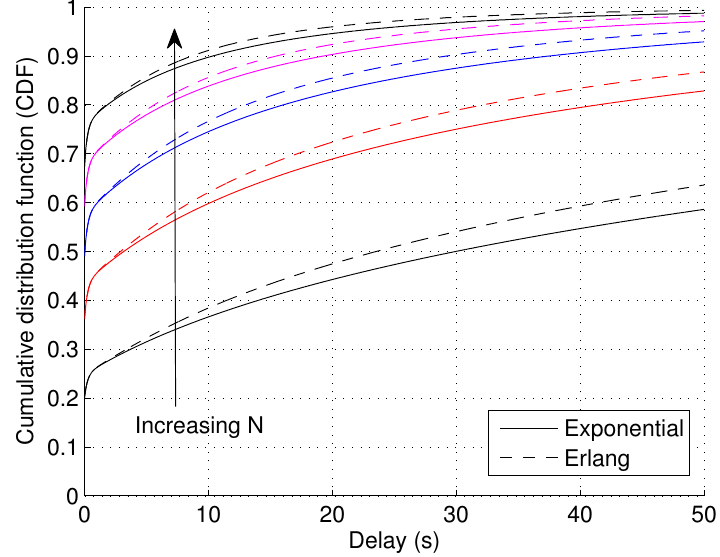
Figure 7. CDF of waiting time w II with varying number of collaborating devices N when the service outage duration β o follows the exponential and Gamma distribution ( N increases from 1–5 with steps of one, k = 2, ε o = 0.6, ¯ α o = 20, ε e = 0.2, ¯ α e =